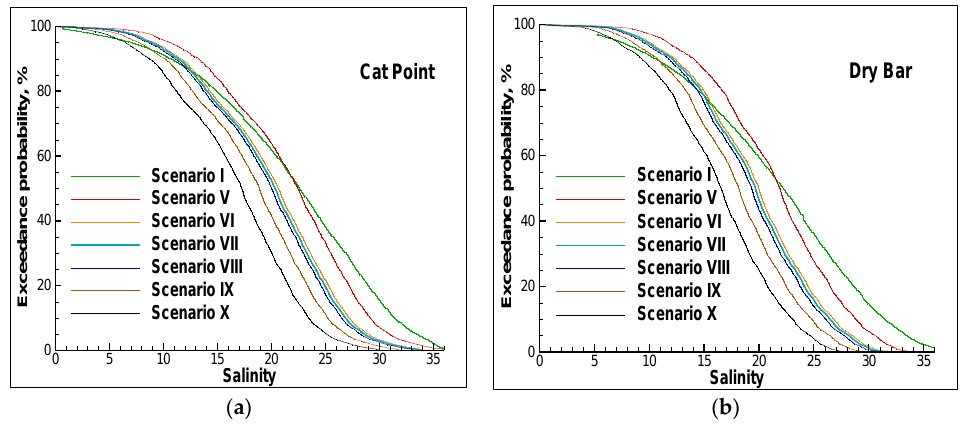
Figure 9. Exceedance rate of daily average salinity at ( a ) Cat Point; and ( b ) Dry Bar stations. Scenarios I, V–X.